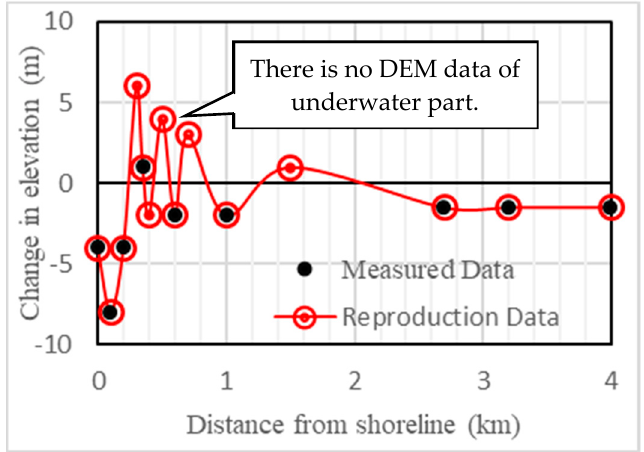
Figure 9. Relative accuracy of the topography-change along line A of the measured data vs. the reproduced simulation result.